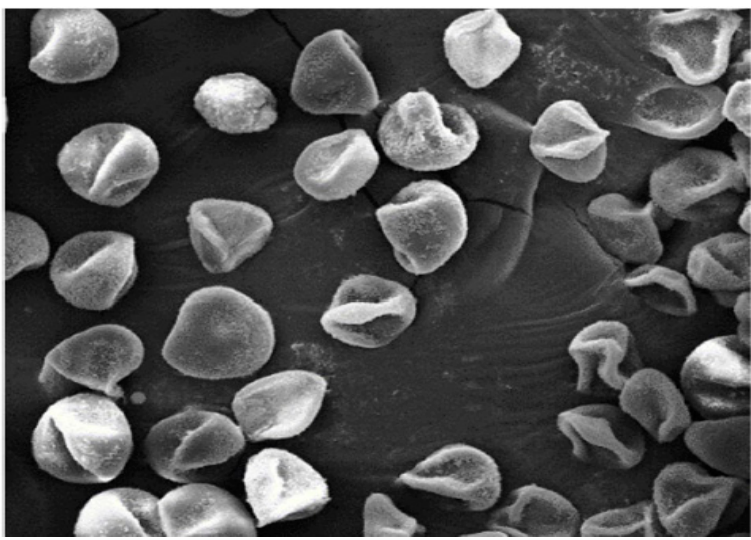
Figure 1. Scanning electron microscopy of lycopodium biofuel particles [22].